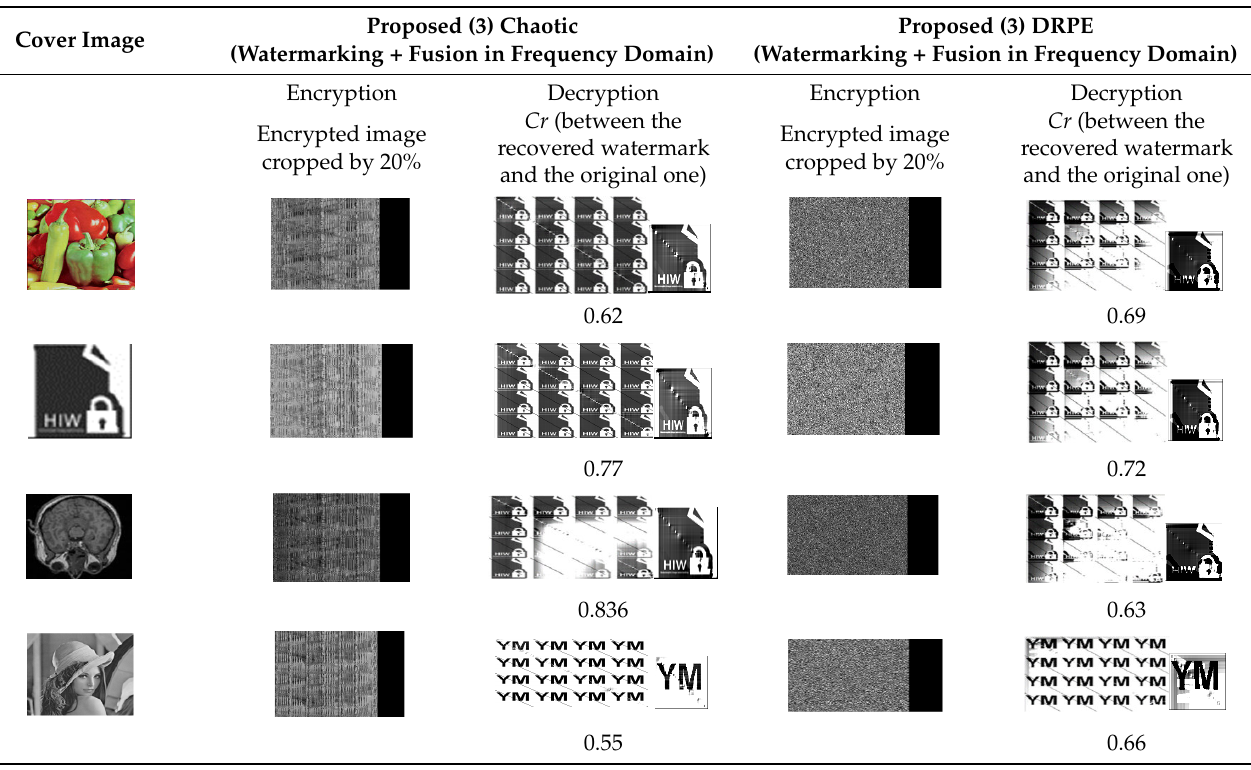
Table 11. Cropped images and corresponding extracted watermarks for the third proposed technique.